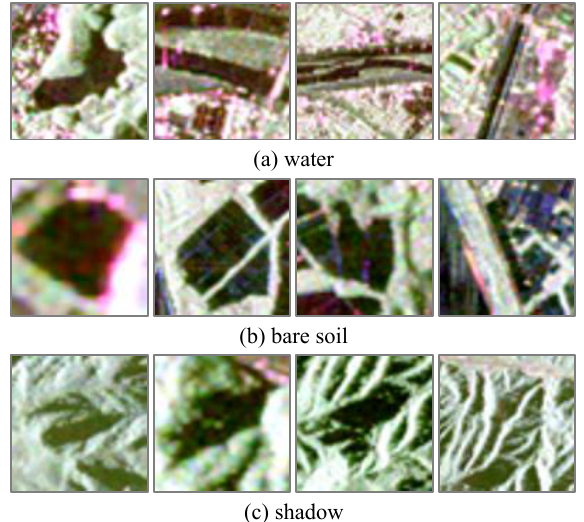
Figure 2. The training scenes selected for supervised